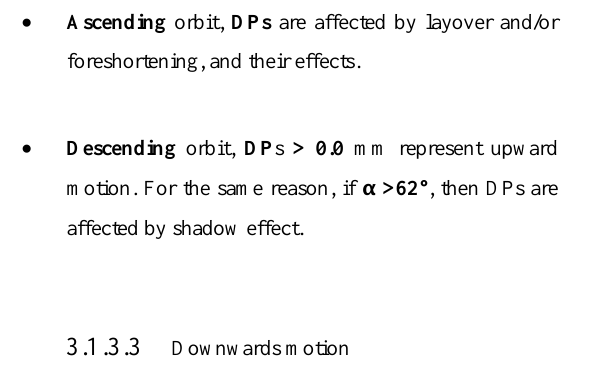
Figure 4. The assumed minimum view range of movement detection, i.e. 30° in pro et contra flight direction for ascending pass as an